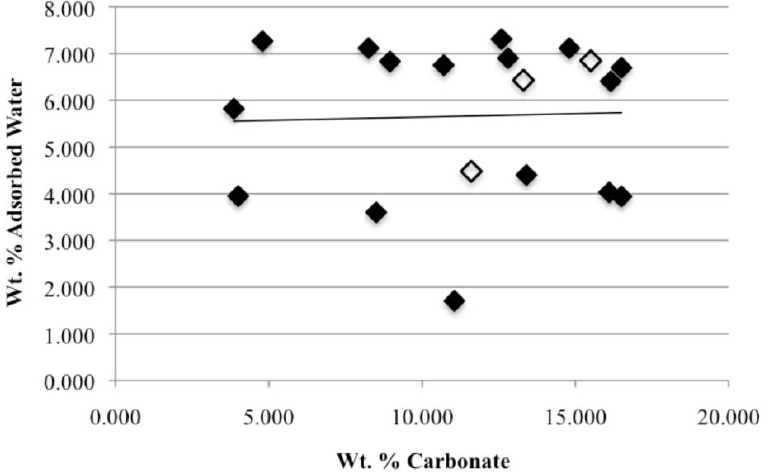
Figure 2. Weight percent adsorbed water as a function of weight percent carbonate in 20 carbonated hydroxylapatite samples synthesized with two-hour digestion periods at 60 °C. Hollow diamonds indicate a synthesis and digestion at 80 °C. The linear regression line for all points is shown.